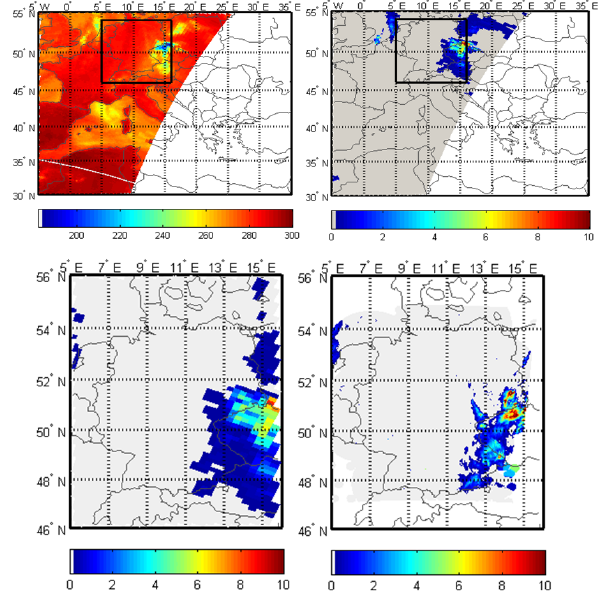
Figure 8. Convective precipitation over Germany, 7 August 2010, 09:51UTC. Top panels: map of MHS (MetOp-A) TB (K) at 150GHz (left), and PNPR surface precipitation rate (mmh − 1 ) (right) (rectangles show the approximate area covered by the radar measurements). Bottom panels: detail of radar rainfall rate estimates (mmh − 1 ) (for the area in the rectangles shown in top panels) ob- tained from radar network RADOLAN, at 09:50UTC (left), and PNPR surface precipitation rate (mmh − 1 ) (right).